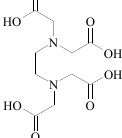
Figure 1. The DAPTA